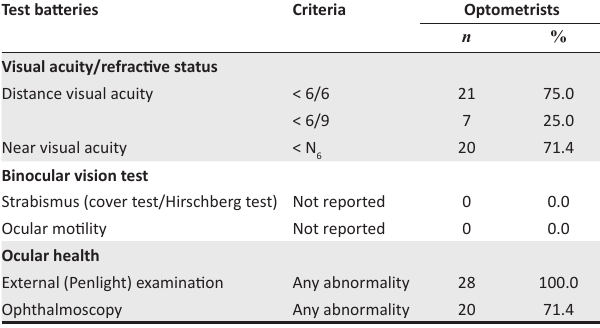
TABLE 4: Referral criteria applied by optometrists for various test